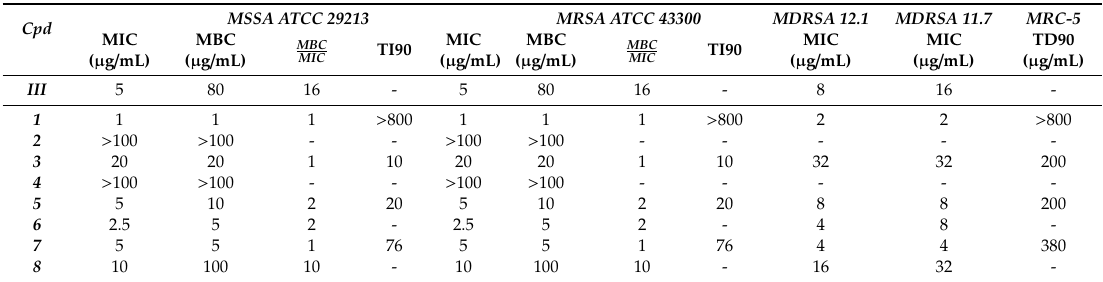
Table 3. Inhibitory activity of compounds III and 1 – 8 against MSSA, MRSA, MDRSA 12.1, MDRSA